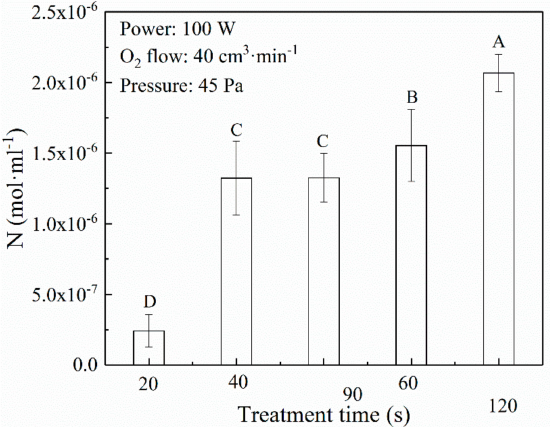
Figure 6. Changes of malondialdehyde (MDA) concentration with increasing the plasma treatment